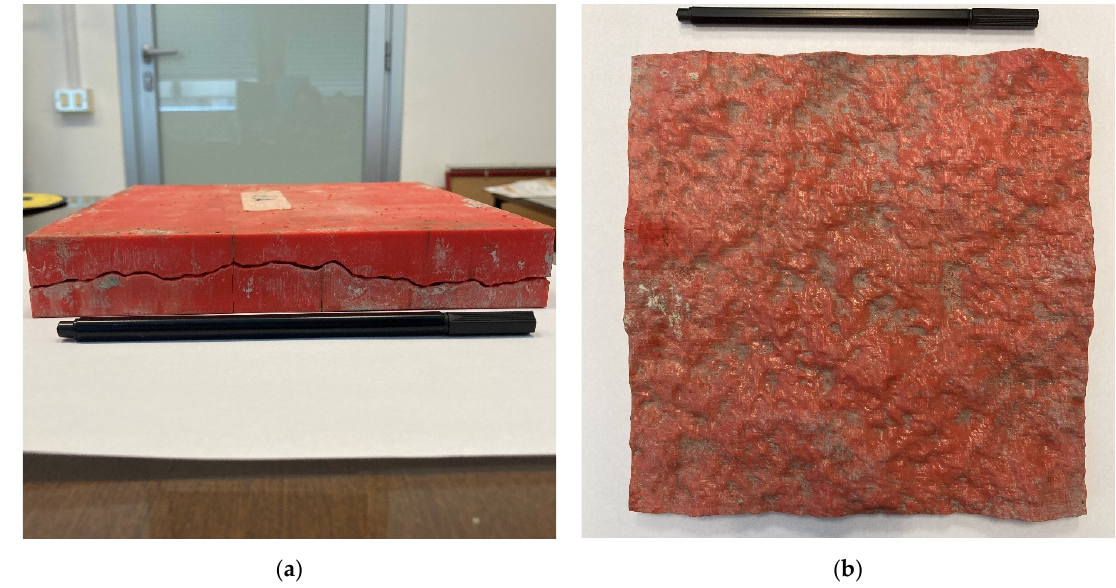
Figure 2. Realization of the synthetic fracture ( a ) 3D printed fracture mold; ( b ) synthetic fracture bottom surface. The length of the pen in figure is 165 mm.